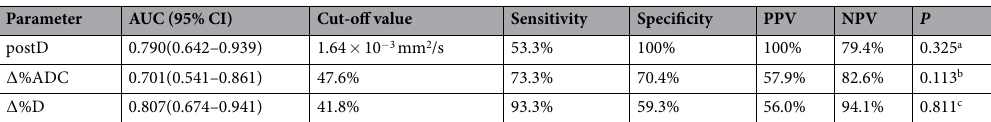
Table 5. Diagnostic efficacy of the IVIM-DWI parametric values in the differentiation between the GR and PR groups. IVIM-DWI, intravoxel incoherent motion diffusion-weighted imaging; GR, good response; PR, poor response; D, pure diffusion coefficient; ADC, apparent diffusion coefficient; AUC, area under the curve; CI, confidence interval; PPV, positive predictive value; NPV, negative predictive value; a postD vs ∆ %ADC, b ∆ %ADC vs ∆ %D, c postD vs ∆